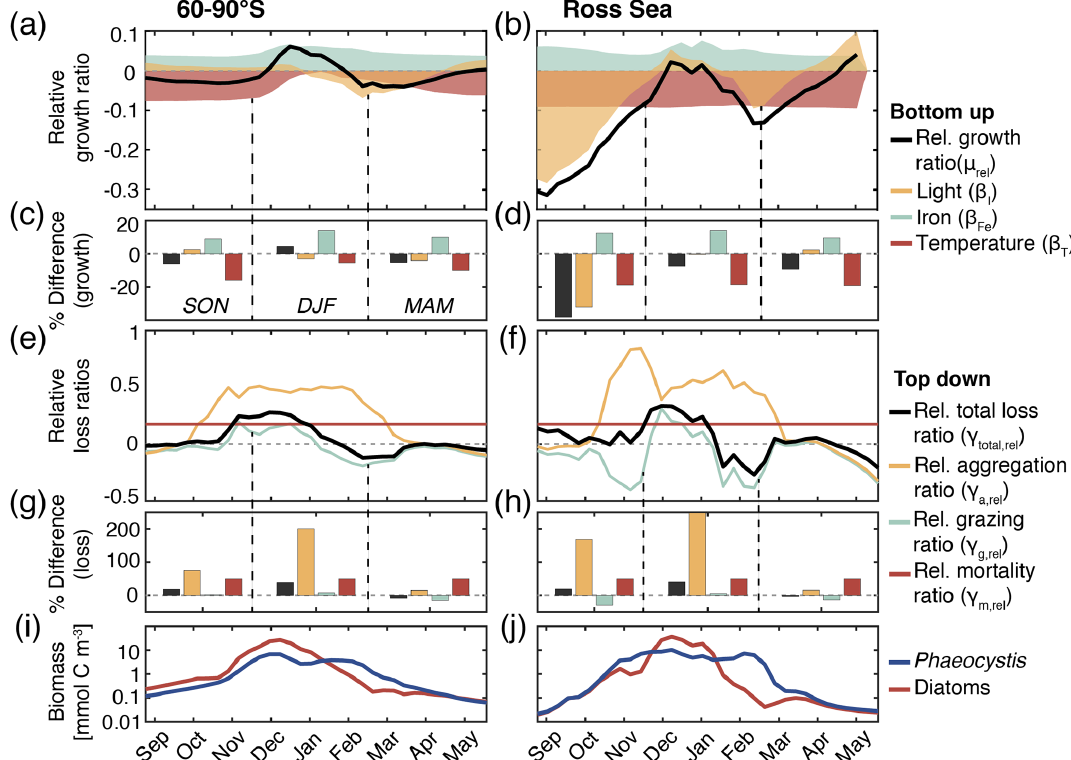
Figure 5. (a, b) Relative growth ratio (black) of diatoms vs. Phaeocystis . The colored areas are the contributions of the limitation of growth by light (yellow, β I ), iron (blue, β Fe ), and temperature (red, β T ; see Eq. 2). (c, d) Seasonally averaged percent difference between diatoms and Phaeocystis in the specific growth rate (black), light limitation (yellow), iron limitation (blue), and temperature limitation (red), calculated DPA from non-log-transformed ratios, e.g., black bar corresponds to 10 µ rel (see Eq. 2). (e, f) Relative total loss ratio (black) of diatoms vs. Phaeocystis , with contributions of the relative grazing ratio (blue), relative non-grazing loss ratio (red), and relative aggregation ratio (yellow; see Eqs. 3–6). (g, h) Seasonally averaged percent difference between diatoms and Phaeocystis in the total specific loss rate (black), specific aggregation rate (yellow), specific grazing rate (blue), and specific mortality rate (red), calculated from non-log-transformed ratios. (i, j) Phaeocystis (blue) and diatom (red) surface carbon biomass concentrations (mmolCm − 3 ). For all metrics, the left panels are surface averages over 60–90 ◦ S and those on the right are for the Ross